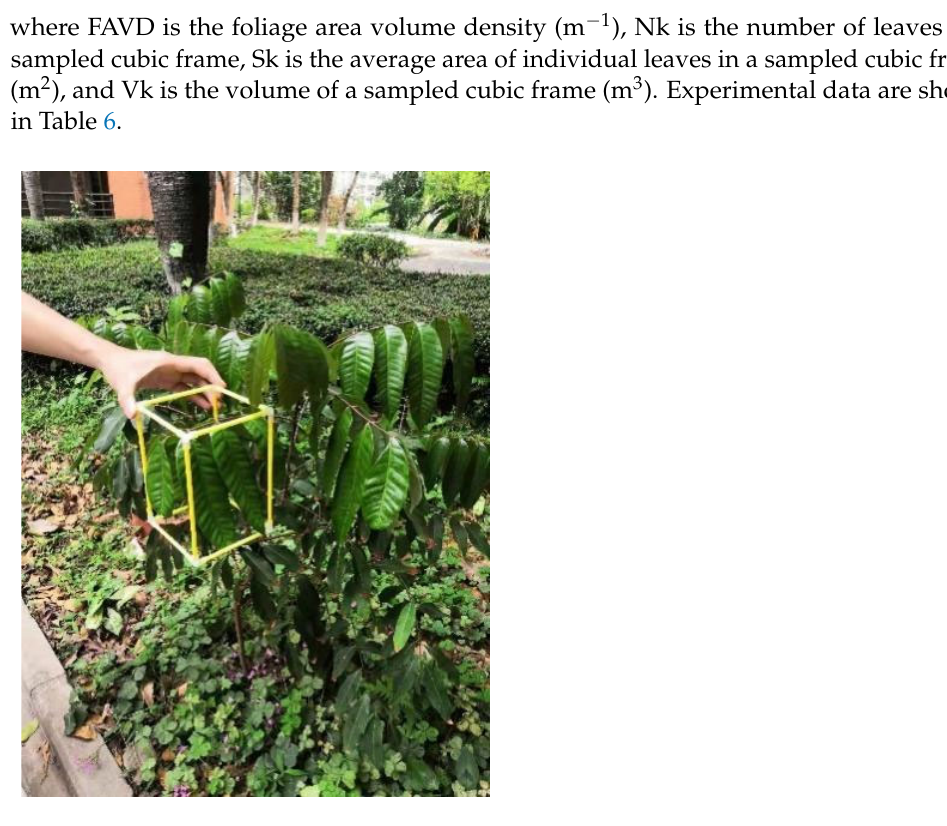
Figure 4. Cubic frame schematic diagram.